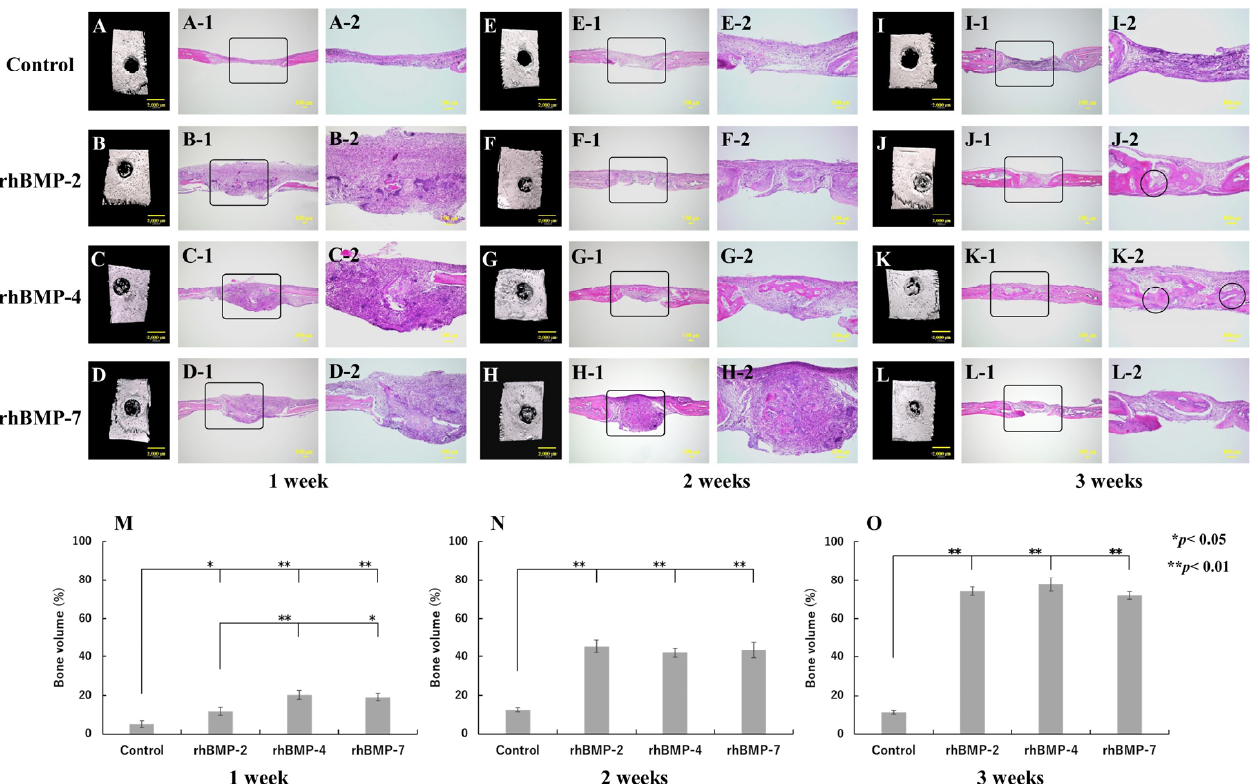
Figure 6. Typical micro-CT ( A – D , E – H , and I – L ) and histological images of each implanted rhBMP- 2, rhBMP-4, and rhBMP-7 sample into the calvarial defects of rats at one, two, and three weeks. ( A , E , I ) are the control. A-2–D-2, E-2–H-2, and I-2–L-2 are magnified insert images in A-1–D-1, E-1–H- 1, and I-1–L-1, respectively. The circles in J-2 and K-2 indicate the areas where the induced new bone integrated with the original calvarial bone. Comparison of the new bone volume of defect area (%) at one ( M ), two ( N ), and three ( O ) weeks after implantation. The data are shown as mean ± SD ( n = 3). Scale bar sizes in micro-CT and histological images are 2000 µ m and 100 µ m,